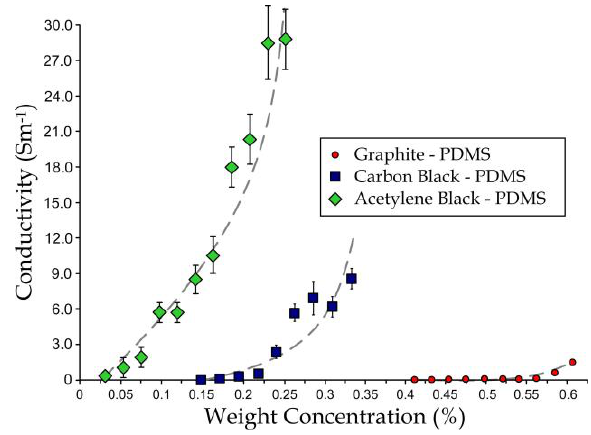
Figure 2. Relationships between concentration and conductivity for graphite-PDMS, carbon black-PDMS, and acetylene